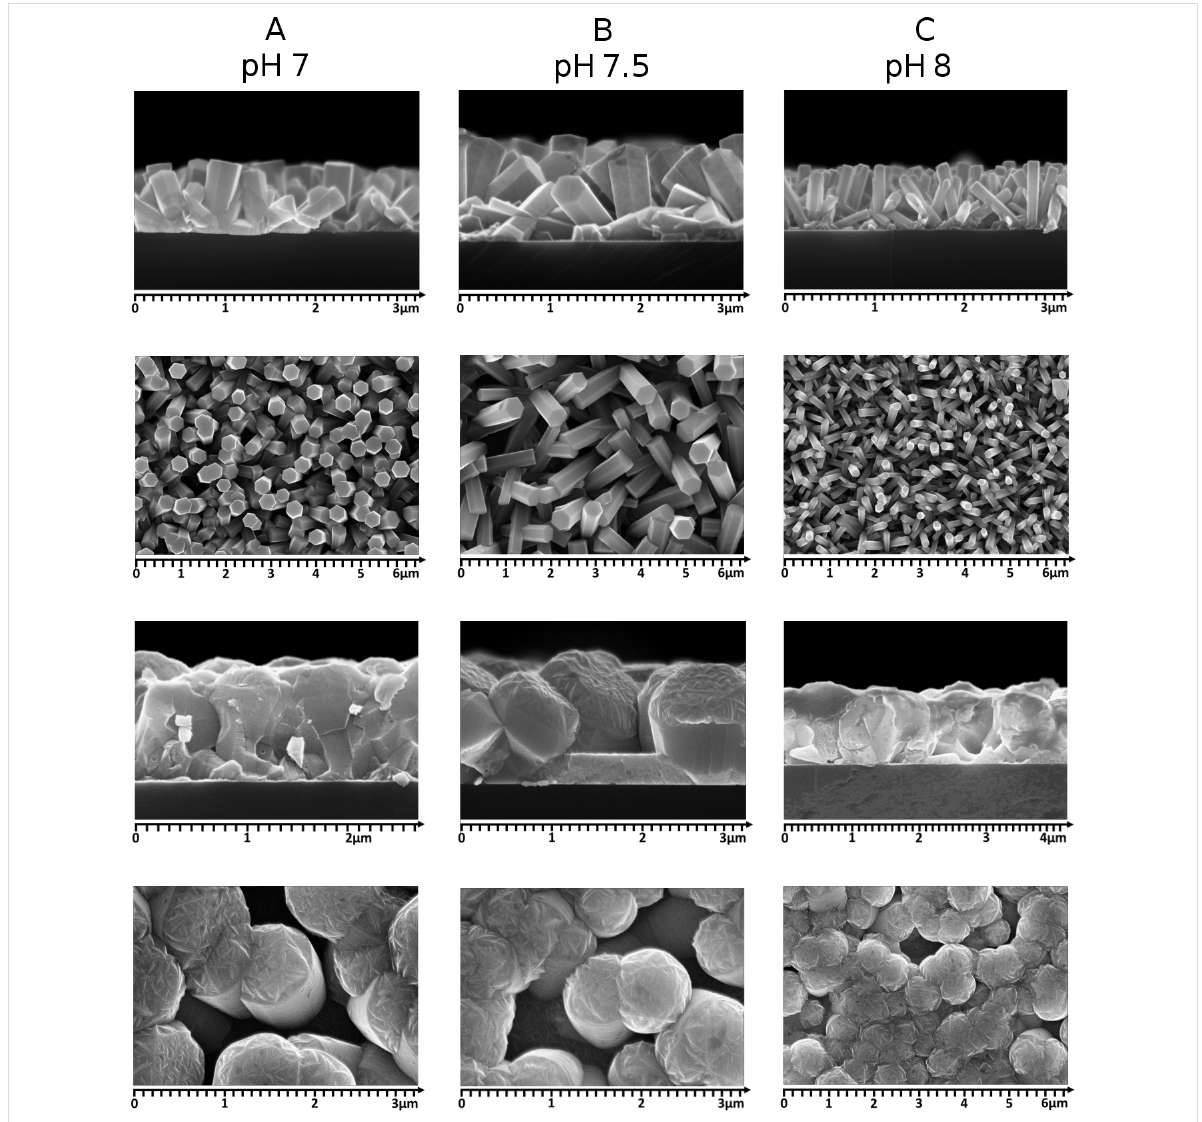
Figure 2: Cross-section and top view (up) SEM images illustrating zinc oxide nanorods grown at different pH values of 7, 7.5 and 8. Images at the bottom show cross-section and top view of ZnONR covered with ZnO:Al layers.